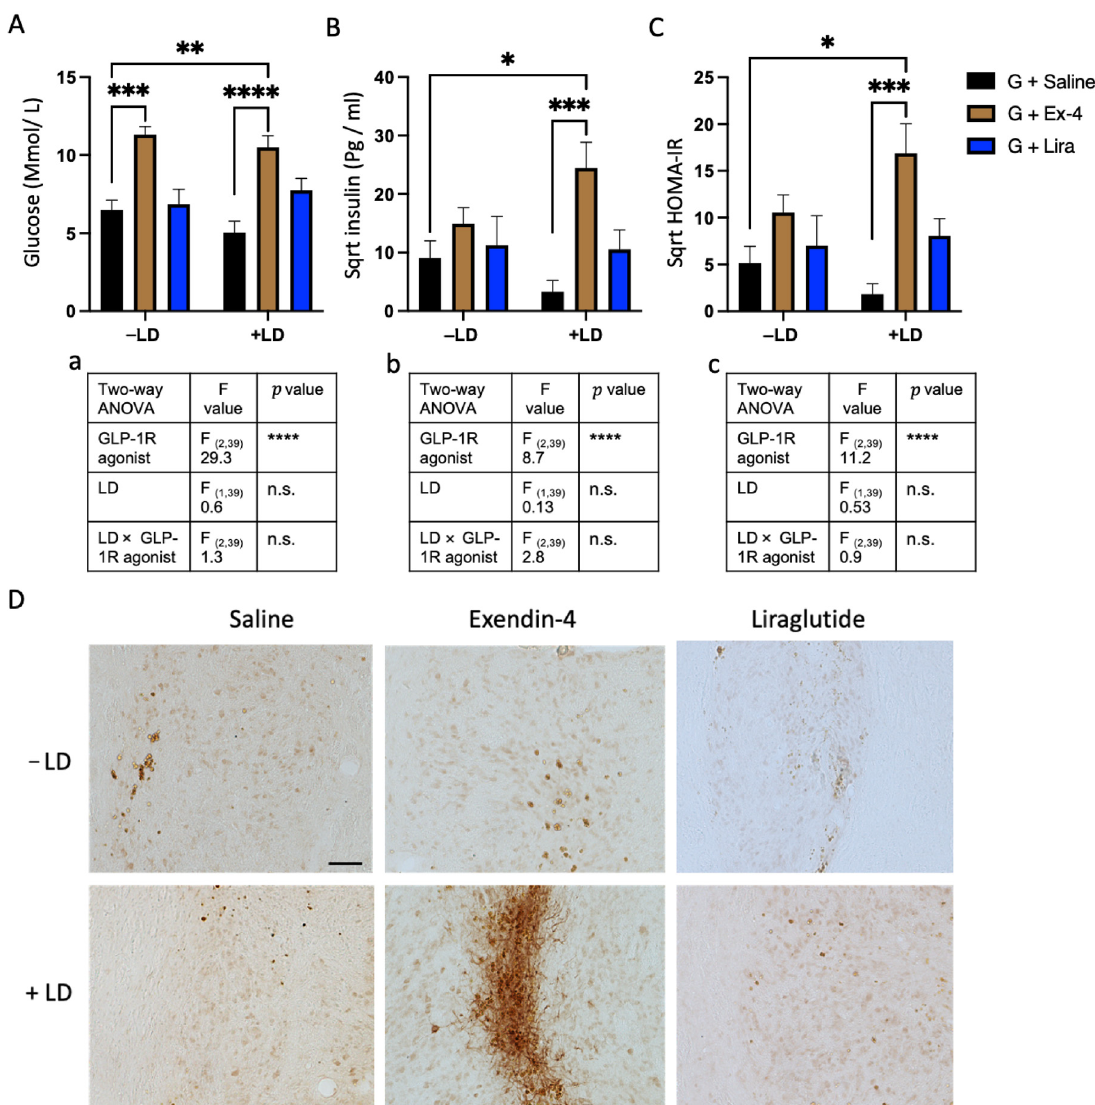
Figure 6. Evaluation of insulin resistance in the plasma in the graft of the transplanted rats: ( A ) glucose level, ( B ) insulin level, ( C ) HOMA-IR value of the transplanted rats received either saline, exendin-4 or liraglutide and +/ − LD. ( a – c ) illustration of statistical sumary of A , B and C analysis respectively. ( D ) bright field images showing phosphorylated insulin receptors labelled with IRS-1 pS1011 in and around the graft of rats received either saline, exendin-4 or liraglutide and +/ − LD. Two way ANOVA * p < 0.05, ** p < 0.01, *** p < 0.001, **** p < 0.0001. n = G − LD (7), G + LD (8), G − LD + Ex-4 (9), G + LD + Ex-4 (8), G − LD + Lira (6), G + LD + Lira (7). n.s. = not significant; LD = L-dopa; Ex-4 = Exendin-4; Lira = Liraglutide. Scale bar = 200 μ m.